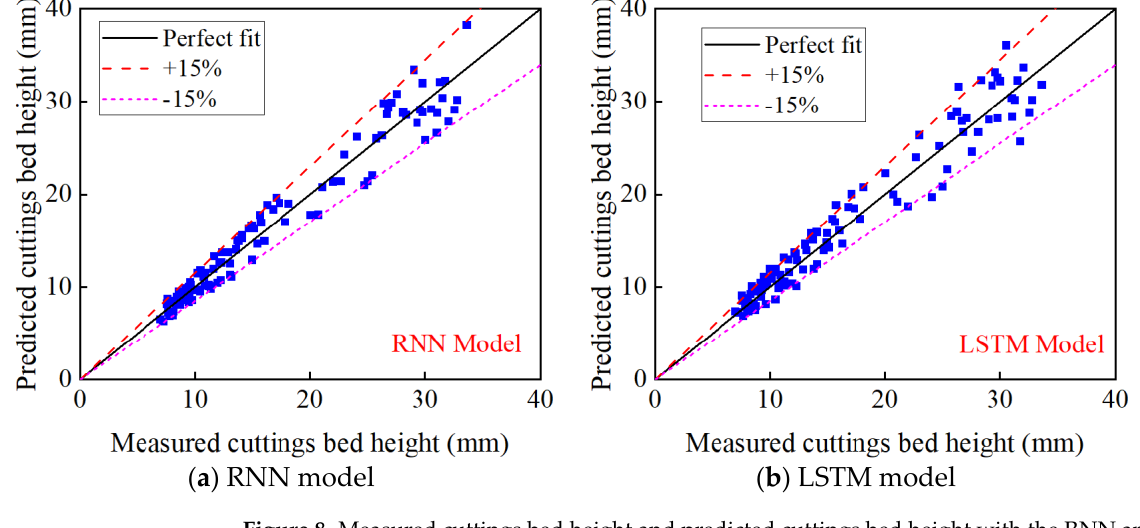
Figure 8. Measured cuttings bed height and predicted cuttings bed height with the RNN and LSTM models ( a ) RNN model, ( b ) LSTM model).